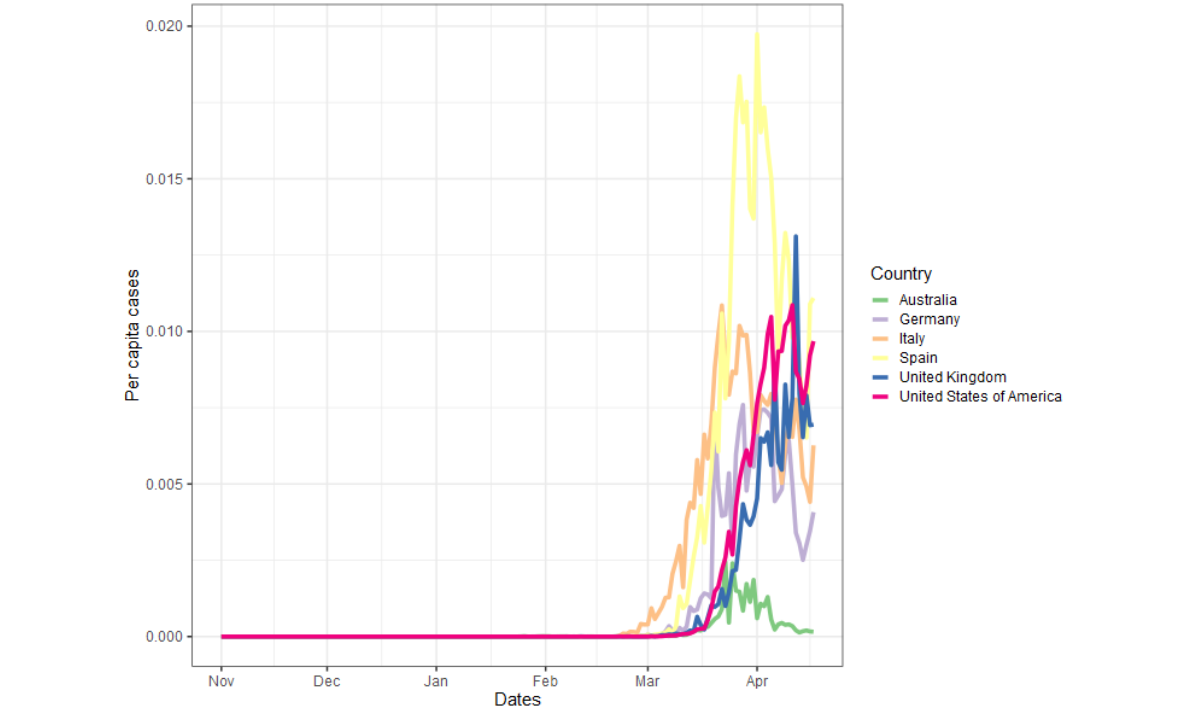
Figure 2. Per capita cases of COVID-19 during the study